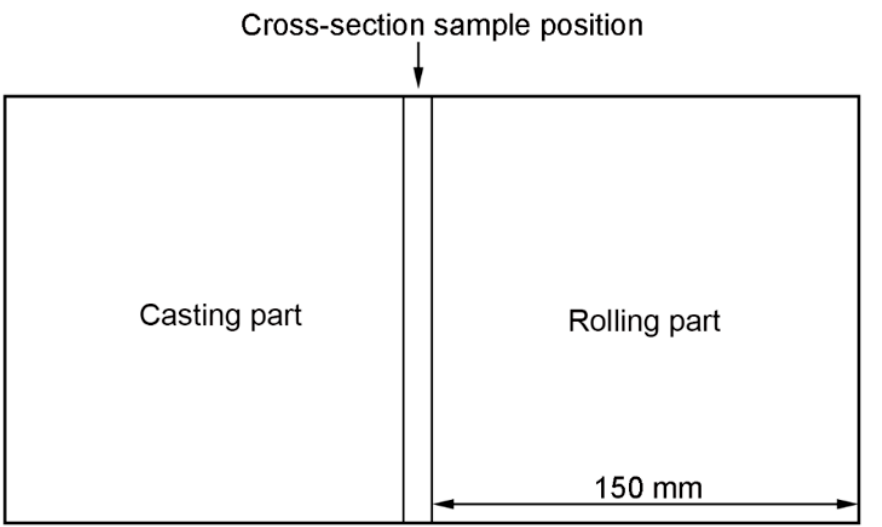
Figure 1. Position of macrostructure sample. Casting part: observe the voids in the billet; rolling part: rolled into a steel plate.